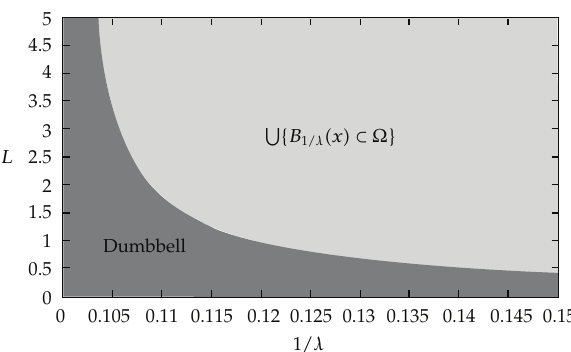
Figure 7: This diagram shows the Σ i with minimum value in (cid:4) 1.2 (cid:5) for the